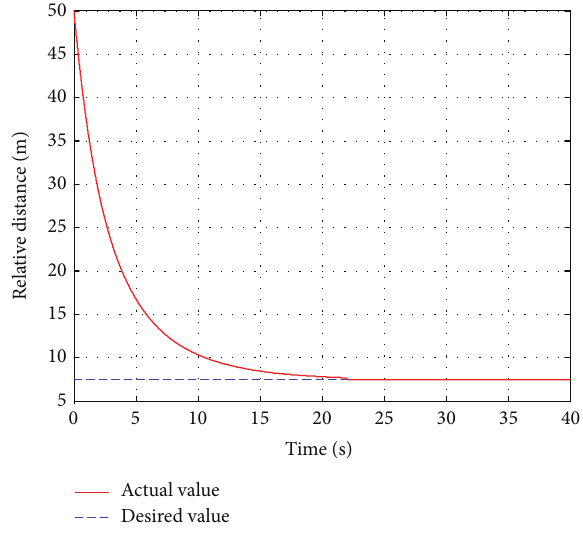
Figure 9: The vehicle deceleration.